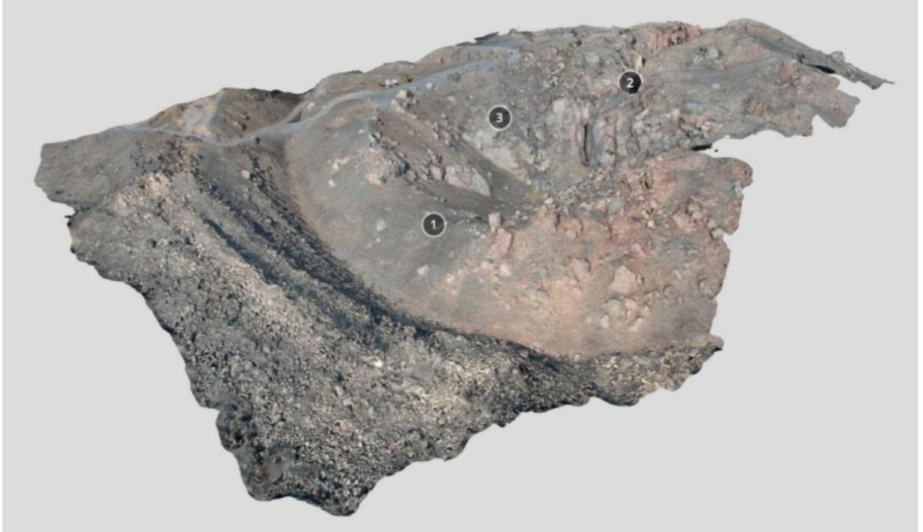
Figure 7. Three-dimensional model of the 1570–1573 AD volcanic crater on Nea Kameni volcano (view towards the northeast) ( pinmarks 1–3